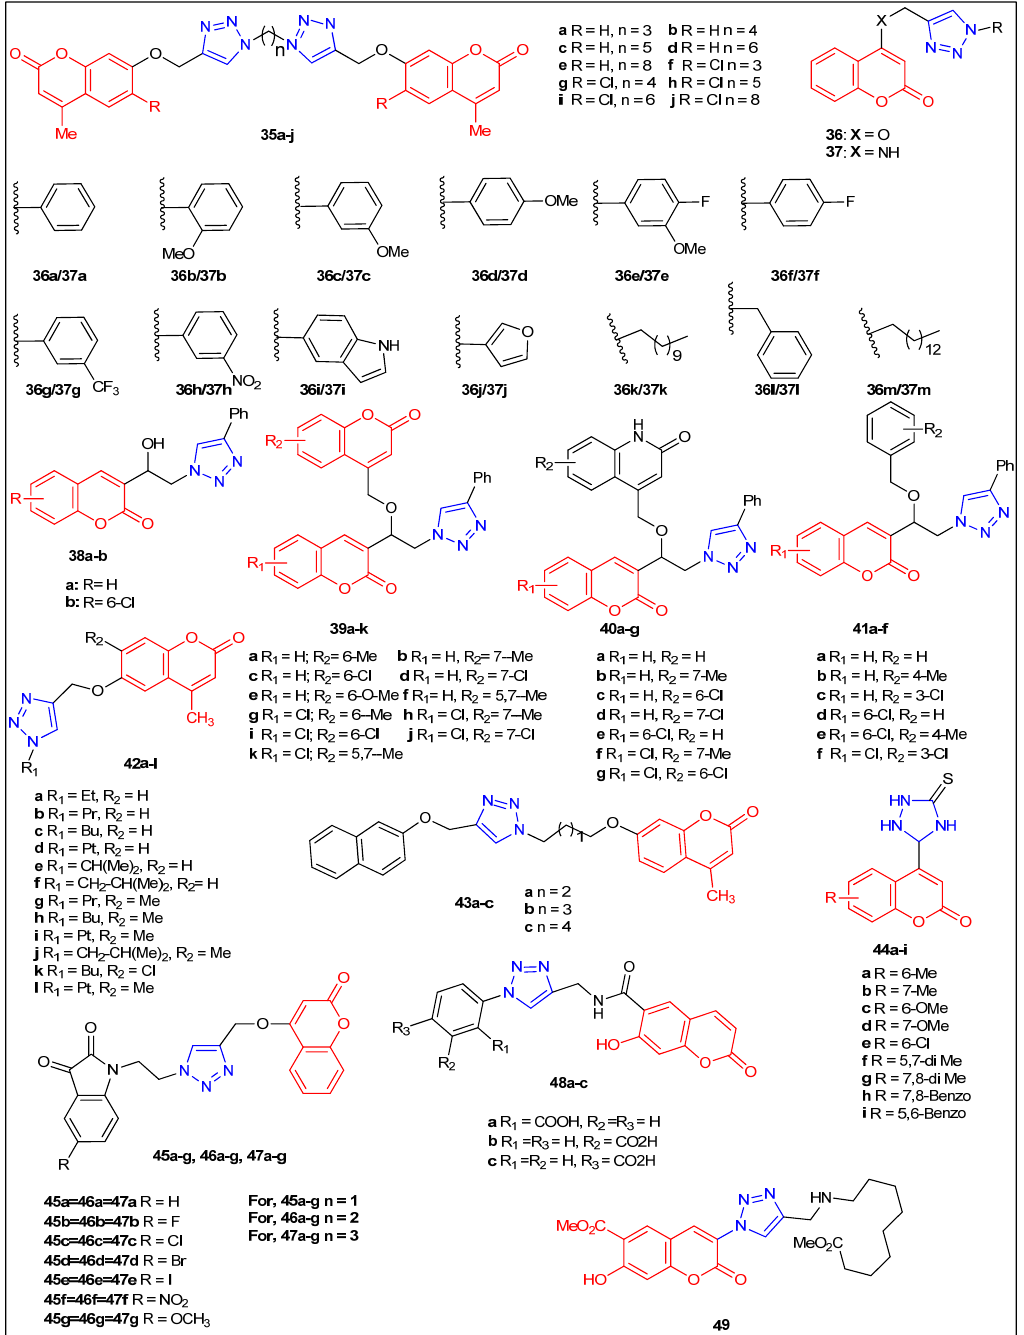
Figure 6. Structures of the reported coumarin triazole derivatives from 2018 – 2019 . In 2018, Savanur et al. [47] established new series of coumarin, quinolinone, and ben- zyl-linked 1,2,3-triazole derivatives ( 38a – b , 39a – k , 40a – g , 41a – f ) via click chemistry, as portrayed in Figure 6, and subjected the molecules to antimicrobial studies. Synthesized coumarin–triazole compounds were screened for antibacterial studies against Gram-pos- itive bacteria, E. coli (NCIM 5346), P. aeruginosa (NCIM 5514), and B. bronchiseptica (NCIM